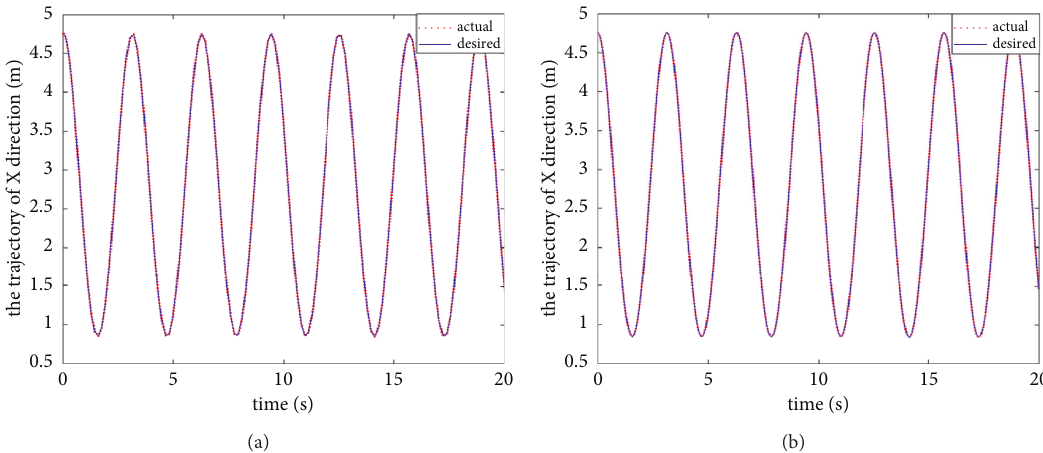
Figure 6: The trajectory tracking of work platform in the horizontal x direction under the action of (a) backstepping control and (b) NN-based backstepping control.